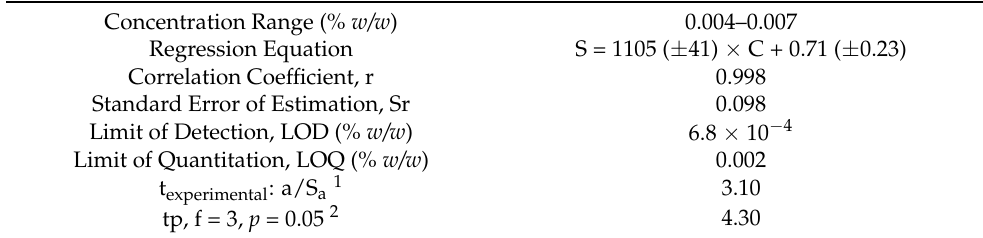
Table 2. Linearity data for the quantitation of acetyl hexapeptide-8 in cosmetic cream as assessed by the HILIC-PDA method.